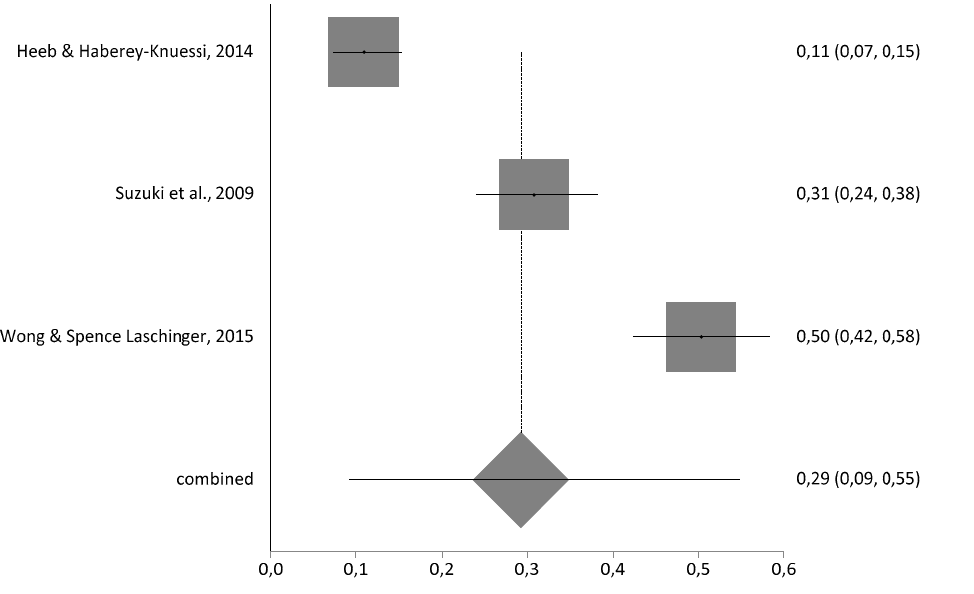
Figure 3. Forestplot of emotional exhaustion prevalence rate.